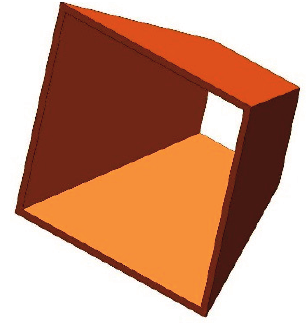
Figure 8. SP-type